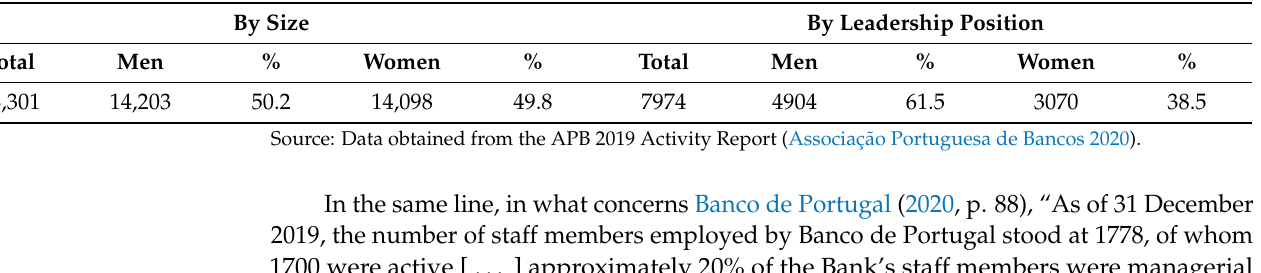
Table 2. APB HR by size and by leadership position.